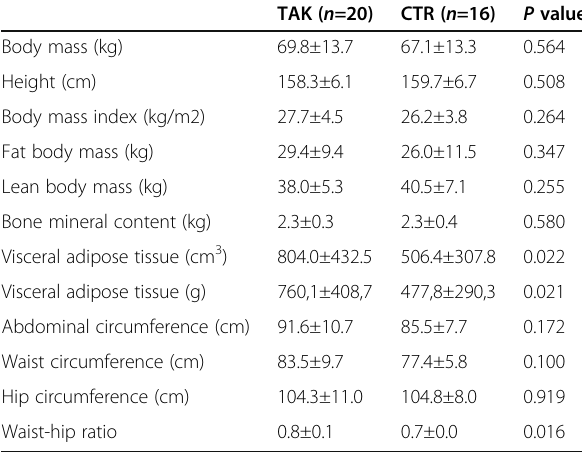
Table 5 Body composition of patients with Takayasu arteritis